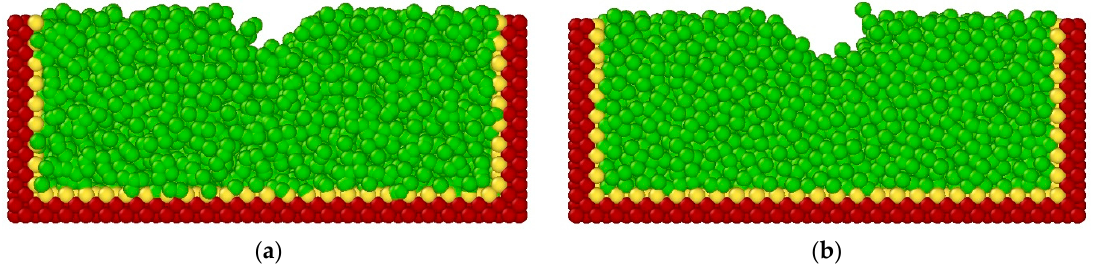
Figure 5. Molecular Dynamics Simulation Snapshot of Cavity Machined on Cu Substrate during ( a ) LBMM Process and ( b ) LA-LBMM Process (Static Mode).